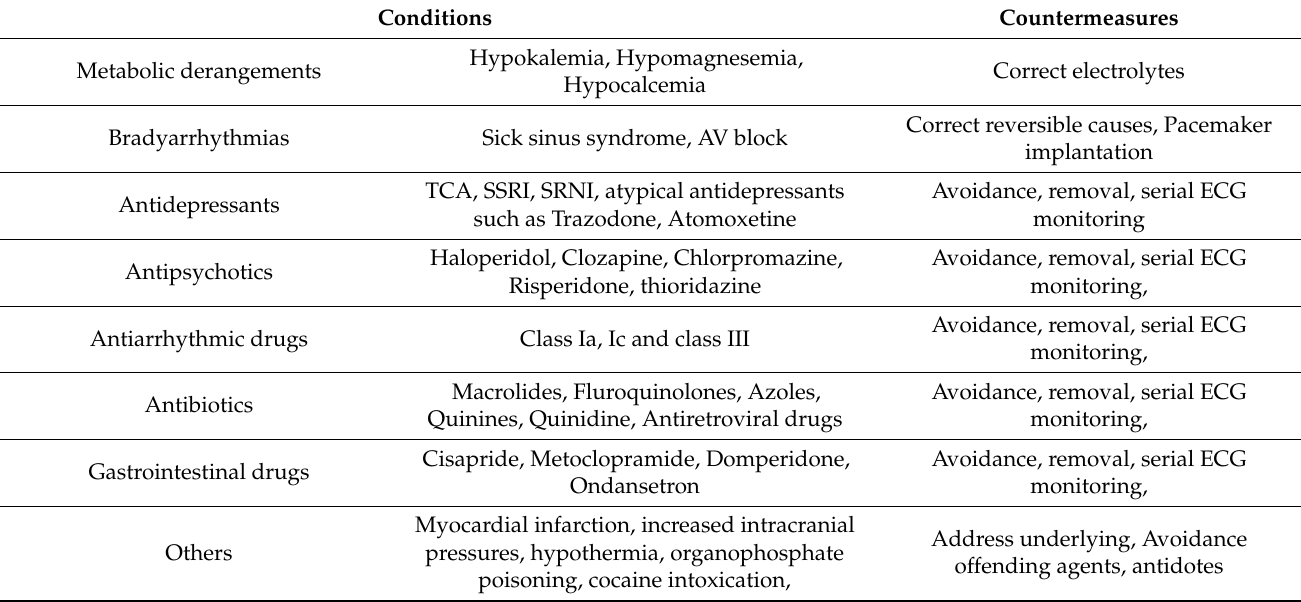
Table 2. Acquired conditions predisposing QT prolongation and TdP